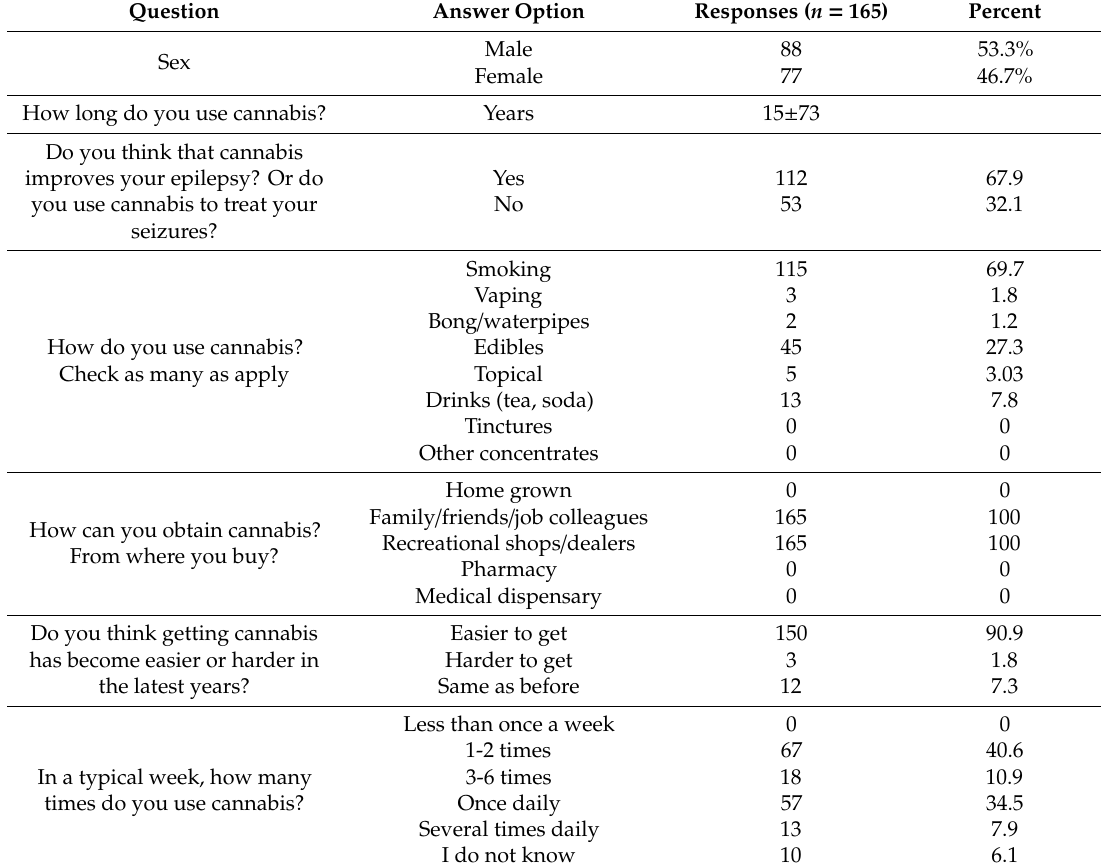
Table 2. Summary of cannabis use survey responses ( n =